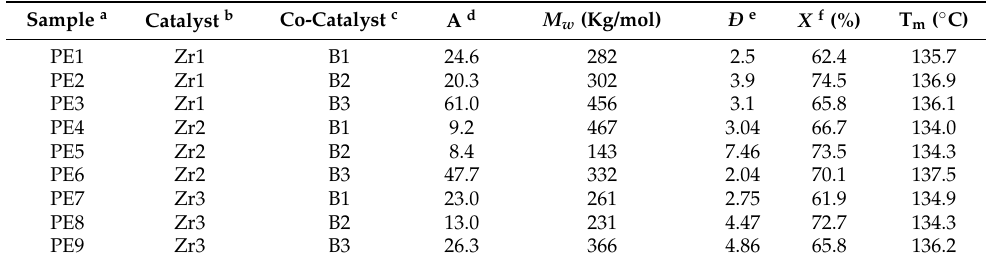
Table 3. General features of the synthesized polyethylene (PE) using different catalytic systems.